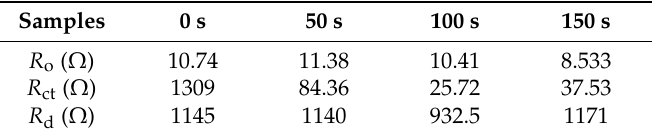
Figure 6. Nyquist plots of electrochemical impedance spectroscopy (EIS) by the Cu oxide-coated carbon cloths with different deposition times. Table 2. Electrochemical impedance fitting results of different cathodes.